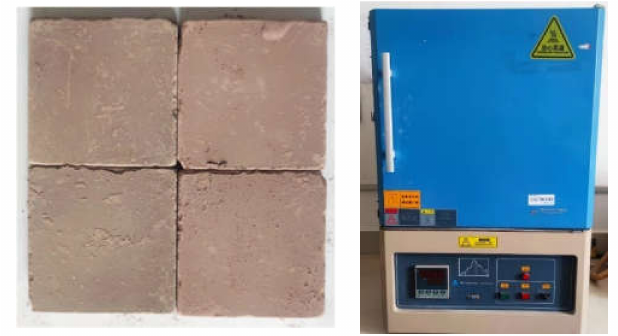
Figure 2. Block cement raw material and high-temperature